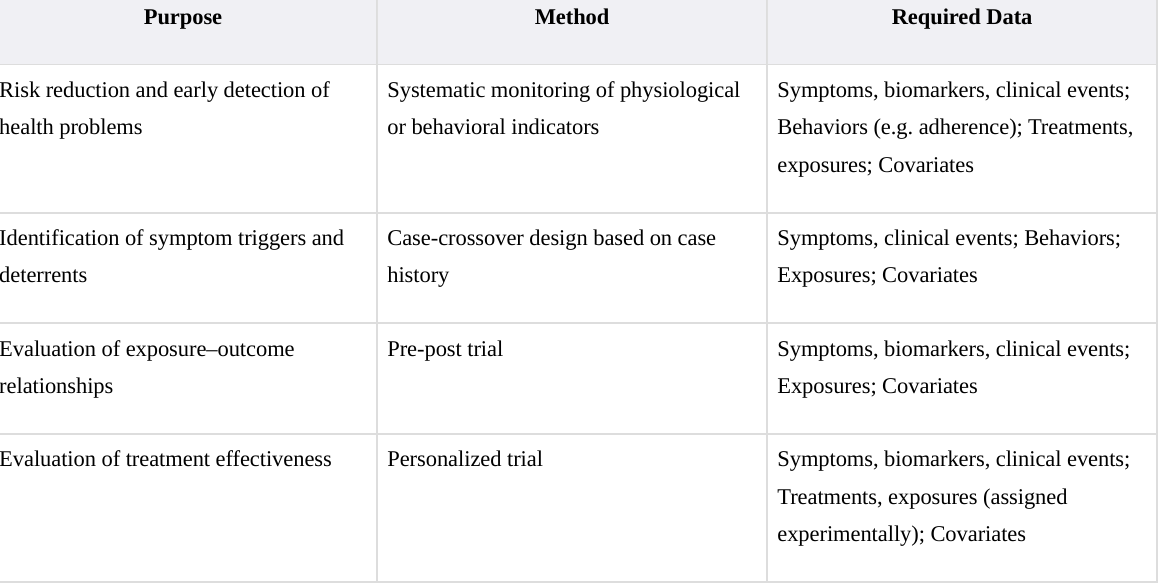
Table 3. Typology of personalized data science (Per-DS)